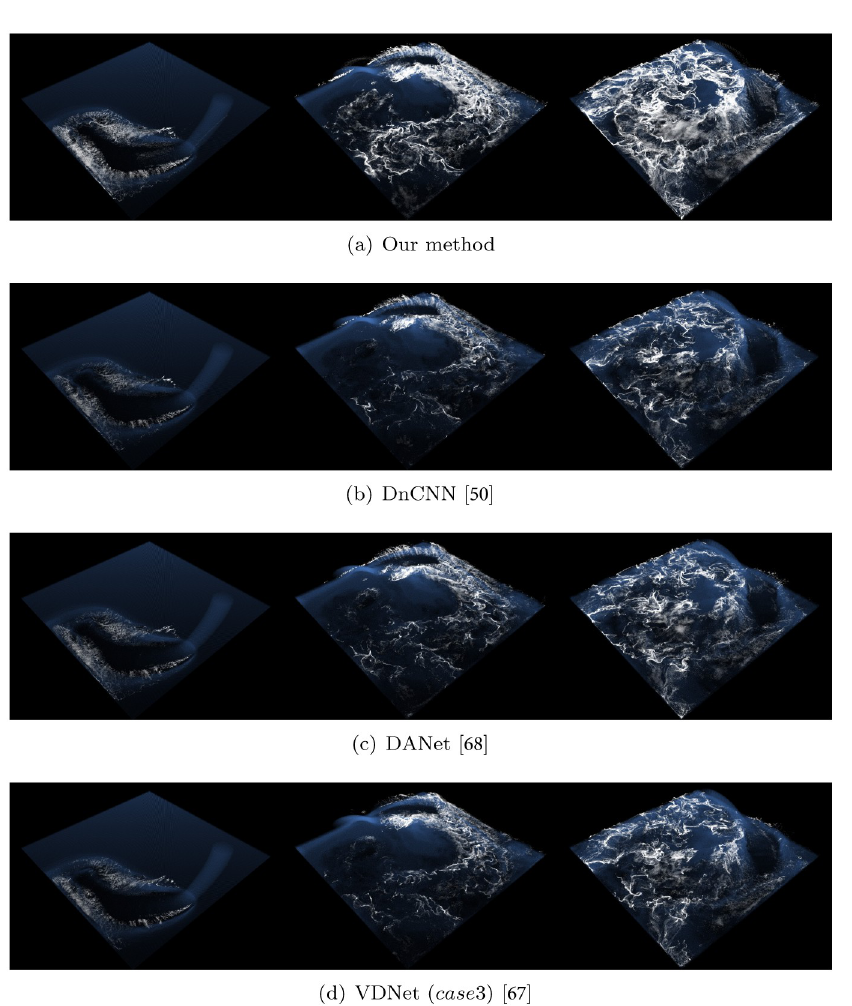
Fig 24. Comparison results with our method and previous approaches ( scene: Rotating - emitter in water ).